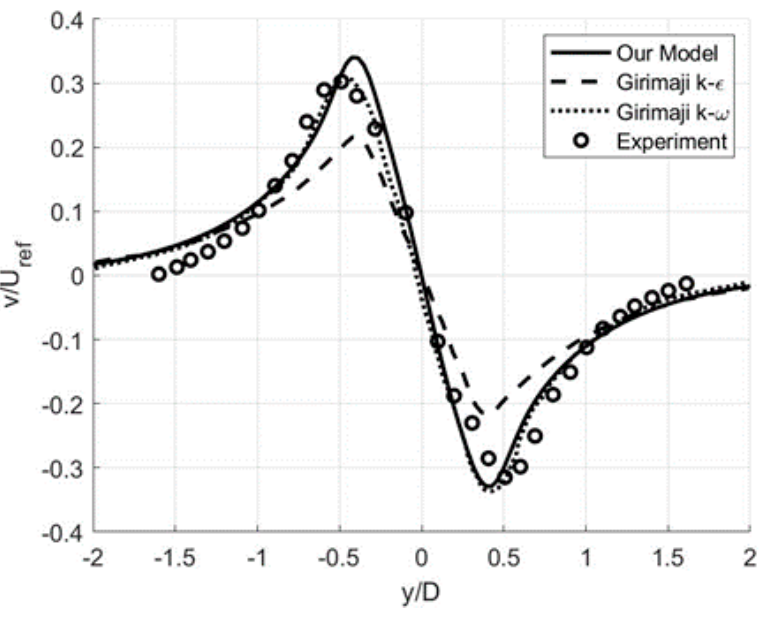
Figure 20. The mean vertical velocity profile at x / D = 1 ( f ε = 1.0, f k = 0.7 ) .